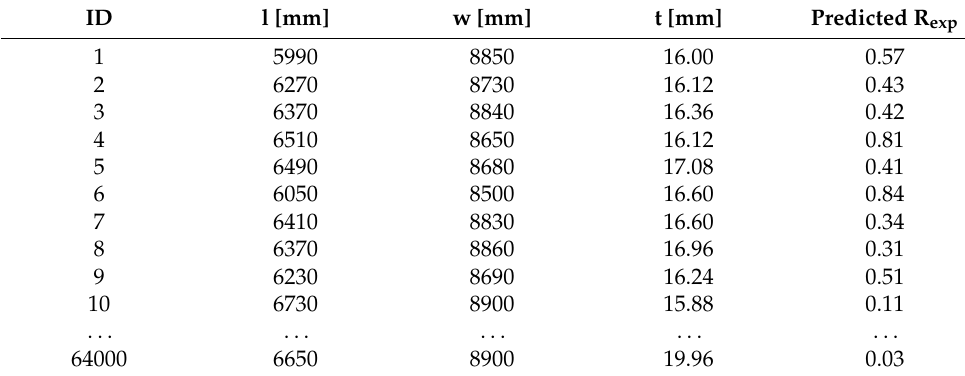
Table 7. Optimization of loop’s geometry.